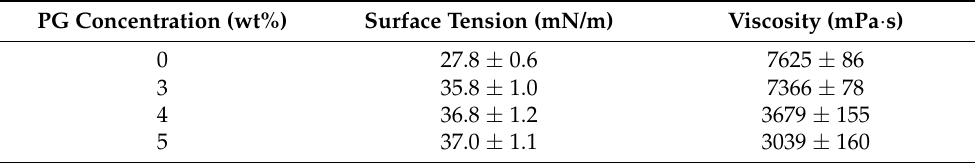
Table 1. Solution characteristics for the studied polymer solutions all made with 15% ( w/v ) poly-